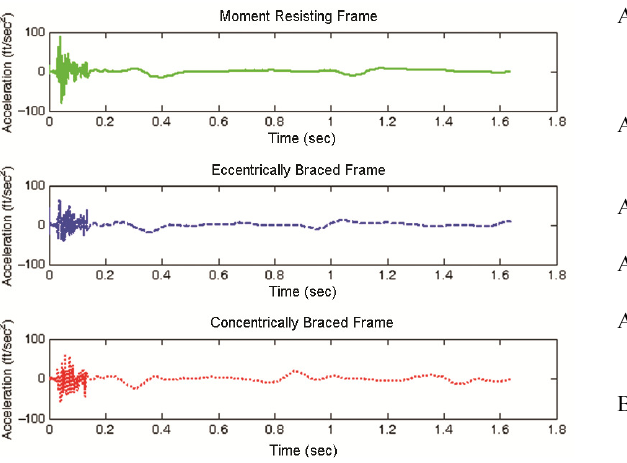
Fig. 15. Roof acceleration under 4-K (17.8 kN) blast (1 ft/sec 2 = 0.31 m/sec 2